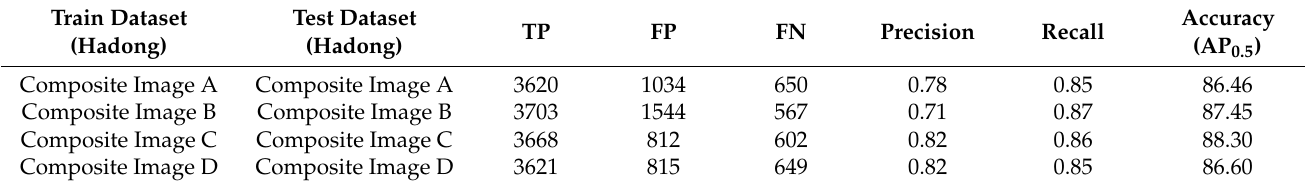
Table 5. Detection accuracy results for individual composite image dataset A~D with tinyYOLOv7 [42].